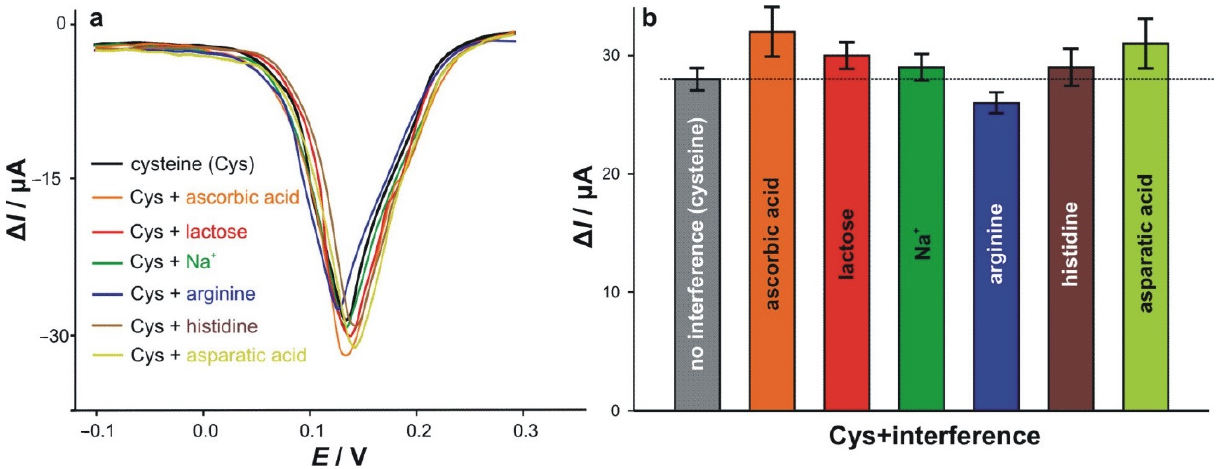
Table 3. Determination of cysteine in real samples by using standard addition method. Sample